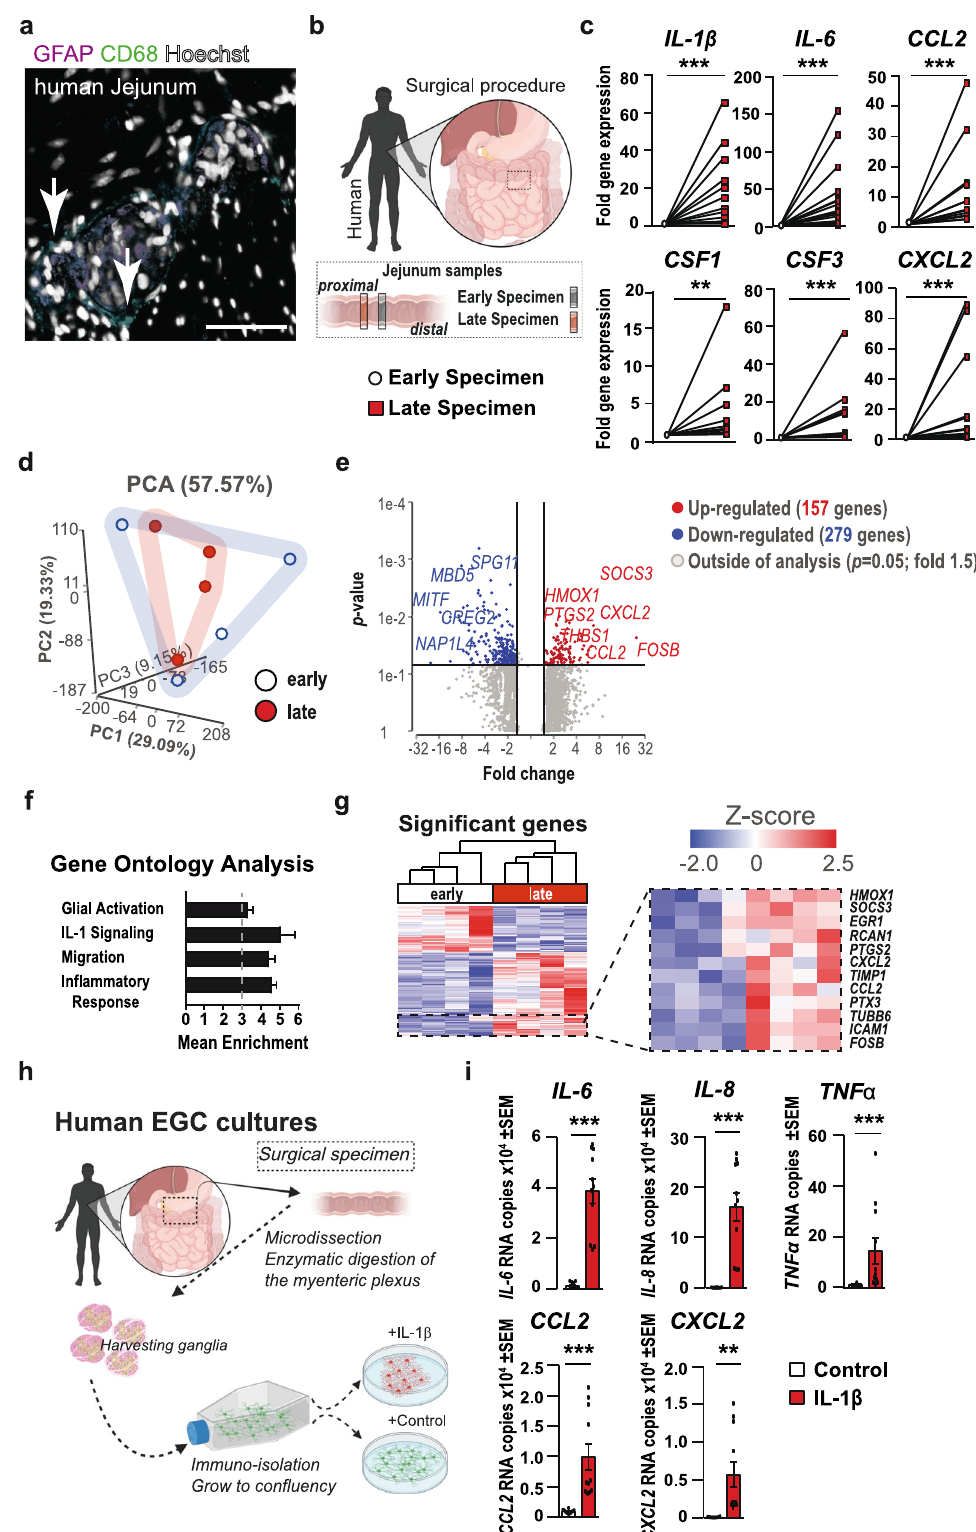
Methods Animals . Experiments were performed using 8 – 12-week-old Sox10- CreERT2 xRpl22 HA/ + or GFAP cre xIL1R1 fl / fl mice kept in a pathogen-free animal facility with standard rodent food and tap water ad libitum. Appropriate authorities of North-Rhine-Westphalia, Germany (81-02.04.2016.A367) approved experiments.